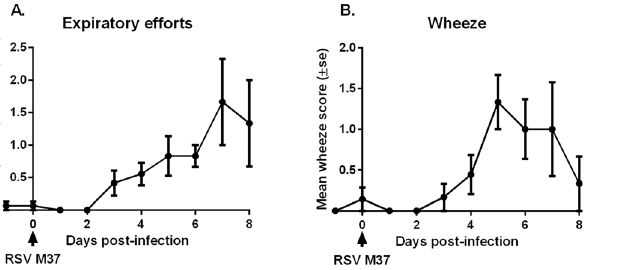
Fig 1. Respiratory distress score of lambs inoculated with human respiratory syncytial virus (hRSV) strain Memphis 37 (M37). Respiratory distress score was assessed daily for each lamb by auscultation or visual observation, and was categorized by expiratory effort (A) and wheezing (B) . Results are shown as mean ± standard error.